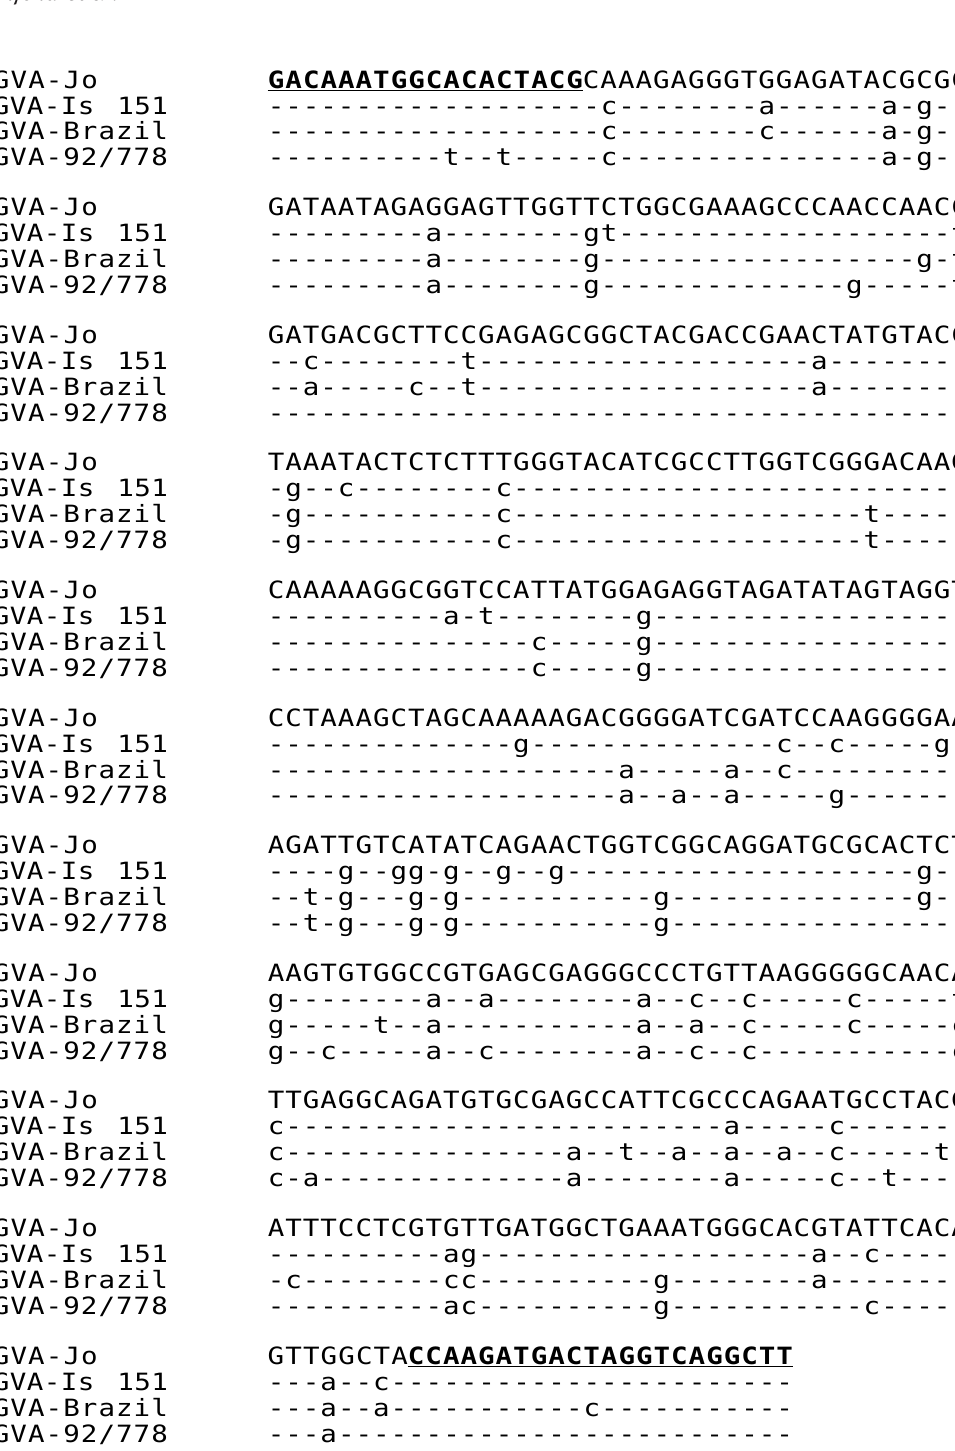
Fig. 3. Multiple alignment of coat protein gene sequences of grapevine virus A from Jordan (GVA-Jo) (GenBank accession No. AY594176), from Italy (GVA Is 151) (GenBank accession No. X75433.1), from Brazil (GenBank acces- sion No. AF494187.1) and from South Africa (GVA 92/778) (GenBank accession No. AF441234.1). Dashed line indi- cates an identical base at a given position. Sequences of H587 and C995 primers are